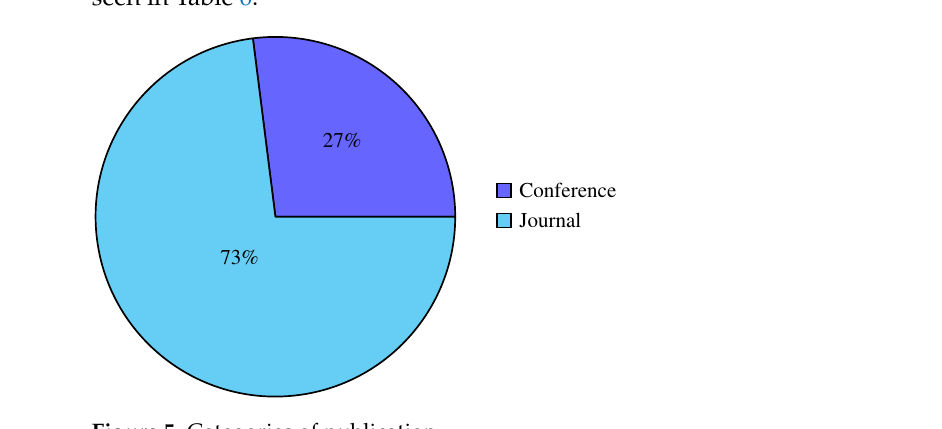
Figure 4. Article distribution by country of origin